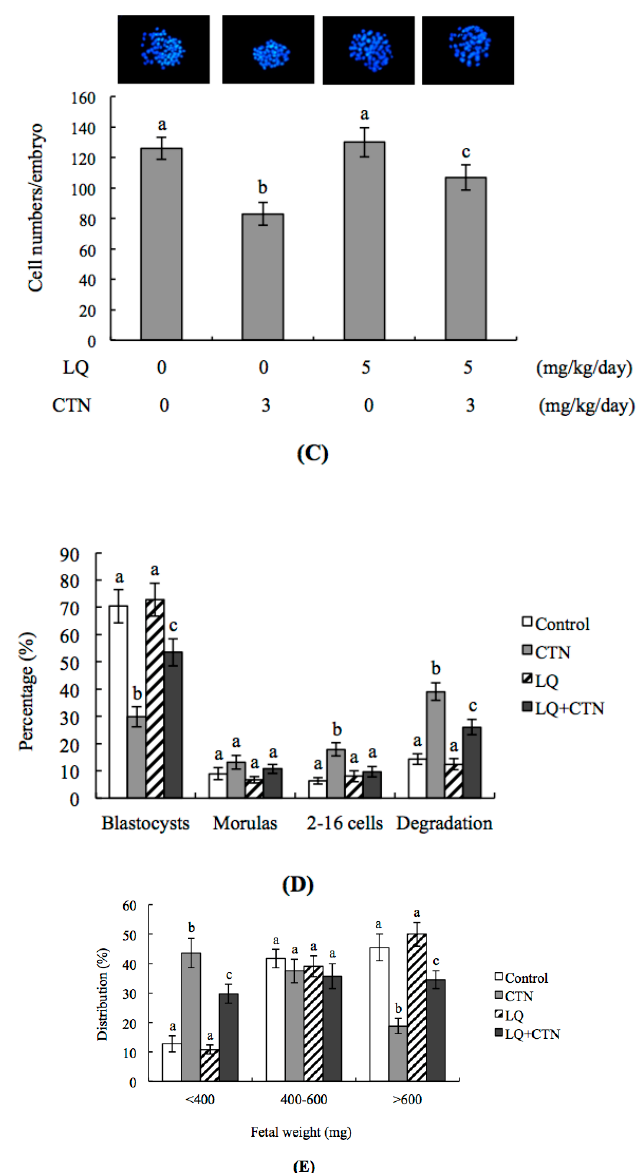
Figure 6. Effects of intravenous injection with LQ and CTN on apoptosis, cell number, pre- and post-implantation embryonic development in an animal model. Twenty randomly selected female mice were intravenously injected with LQ (5 mg/kg/day) for four days and further with LQ (5 mg/kg/day) and CTN (3 mg/kg/day). PBS containing 0.5% DMSO was used as the control (vehicle group). At 24 h after LQ and CTN injection, female mice were mated with male mice overnight. Female mice were continuously intravenously injected with LQ and CTN for an additional four days, and blastocysts obtained by flushing the uterine horn on day four after mating. ( A , B ) TUNEL-positive (apoptotic) cells in LQ- and/or CTN-injected (dosage as indicated) blastocysts were detected. The mean number of apoptotic cells per blastocyst was counted; ( C ) Hoechst 33258 staining was used to count the total cell number per blastocyst under a light microscope; ( D ) Developmental stages of embryos obtained from mouse uterine horns on day four were examined based on morphological analyses under a light microscope; ( E ) The weight distribution of each group of surviving fetuses on day 18 post-coitus was measured. Values are presented as means ± SD of five determinations. Symbols indicate significant differences at p < 0.05.